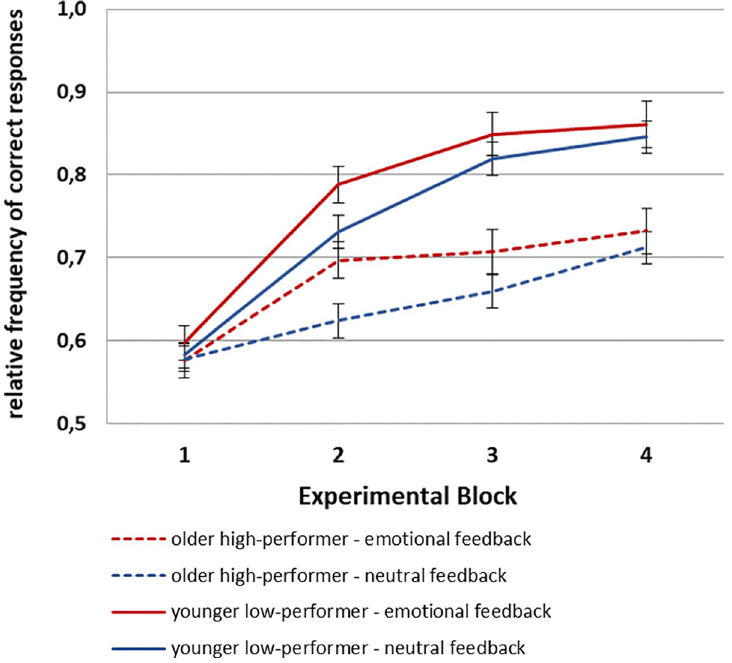
Fig 6. Accuracy data for younger poor-performers and older high-performers in the emotional and the neutral conditions of the probabilistic learning task.